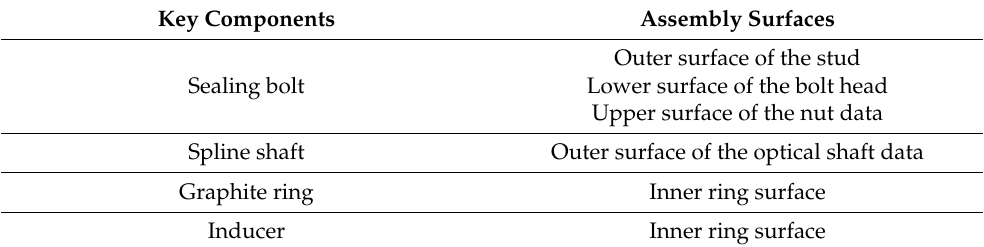
Table 6. Assembly surfaces of the four key components.